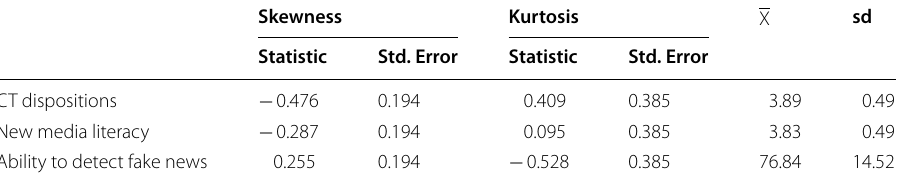
Table 1 Descriptive statistics for the CTDS, NMLS, and FN detection task and skewness and kurtosis values for each instrument Skewness Kurtosis X sd Statistic Std. Error Std.